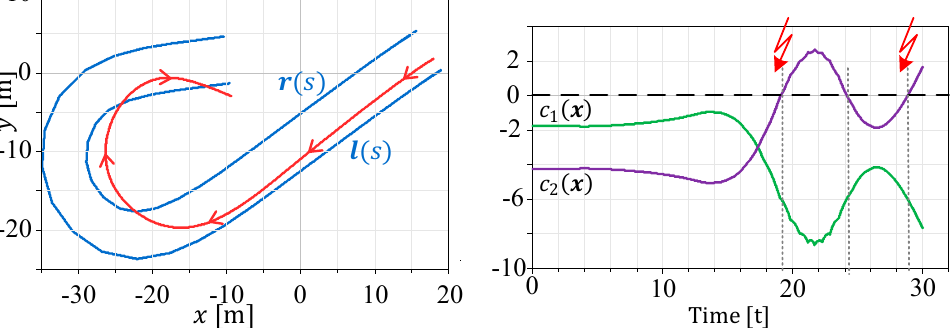
of Figure 6. Sensors 2019 , 19 , x FOR PEER REVIEW